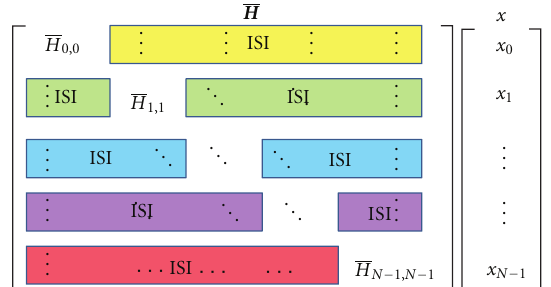
Figure 4: Schematic diagram of intersymbol interference.